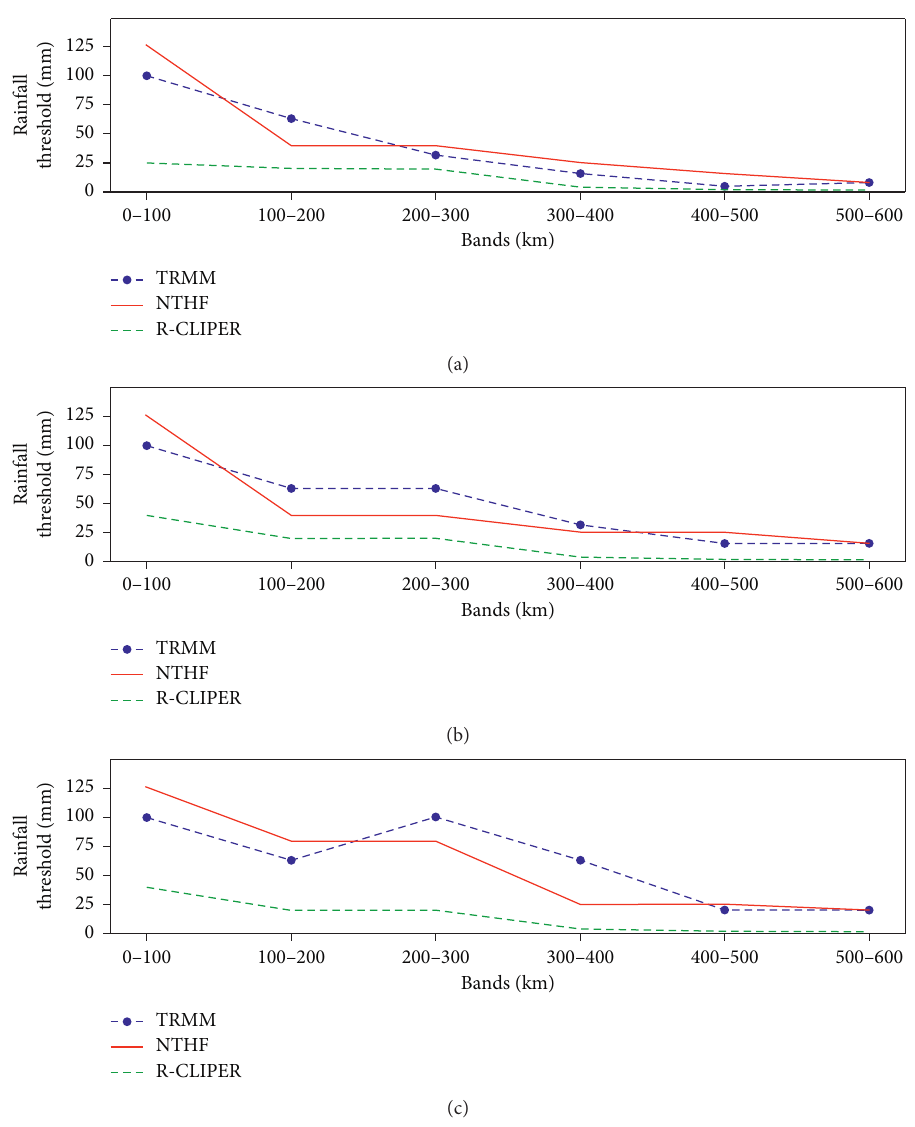
Figure 12: Rainfall thresholds at which maximum frequency appeared for different bands. This figure summarises the results for the TRMM (blue), NTHF (red), and R-CLIPER (green) for (a) 24h, (b) 48h, and (c) 72h